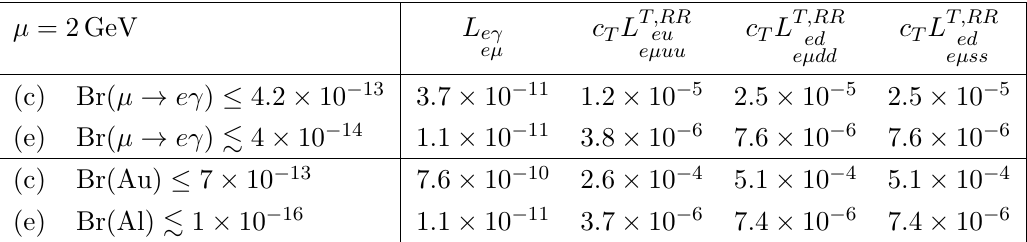
are in units of TeV (cid:0) 1 . They constrain e(cid:22) and c T L T;RR eq (cid:22)e (cid:22)eqq